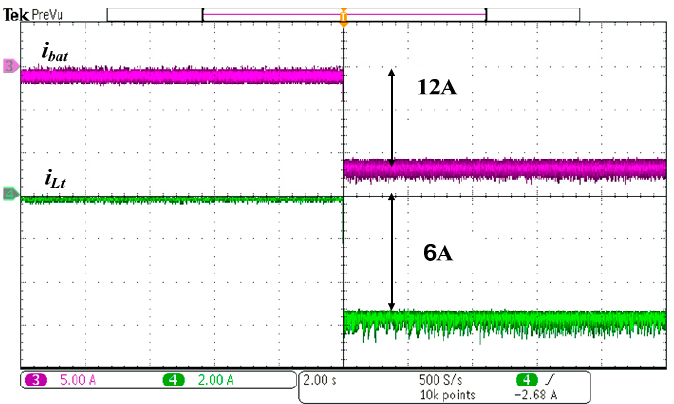
Figure 10. Measured discharging waveform of the proposed high-gain RC-BDC.